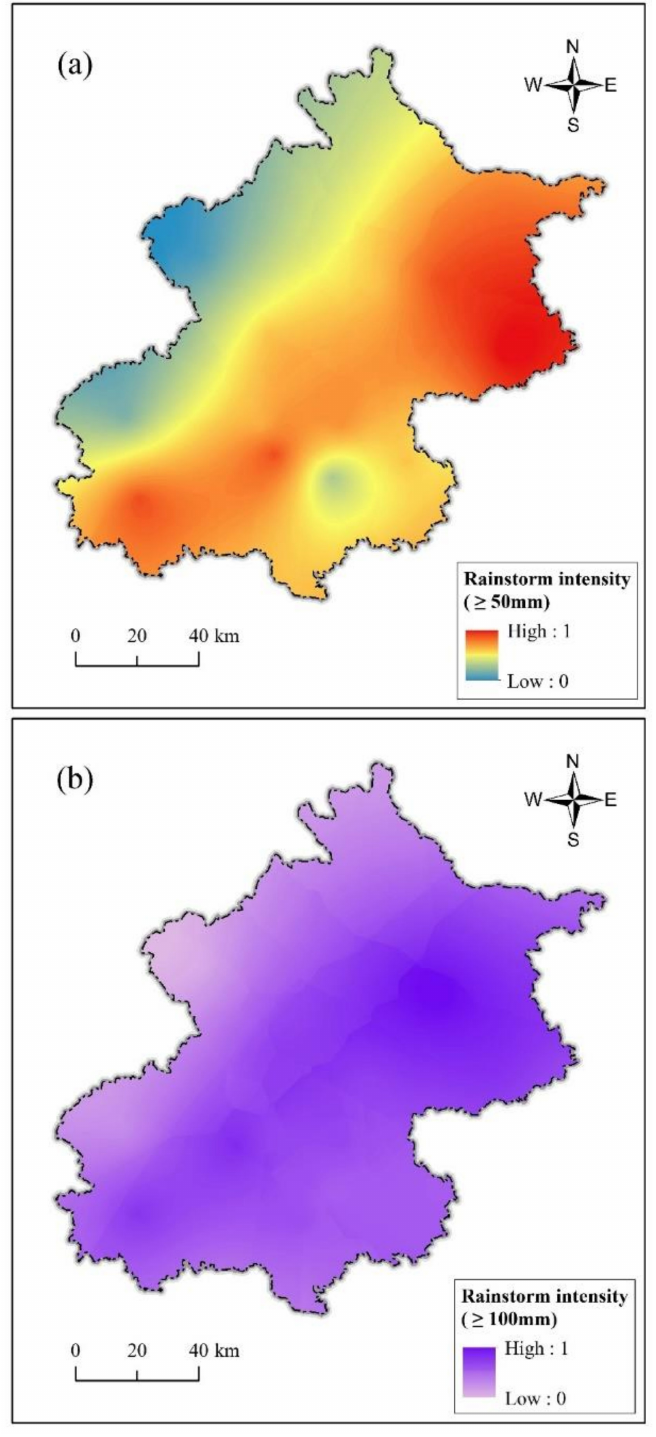
Figure 4. Spatial distribution of precipitation intensity. ( a ) ≥ 50 mm; ( b ) ≥ 100